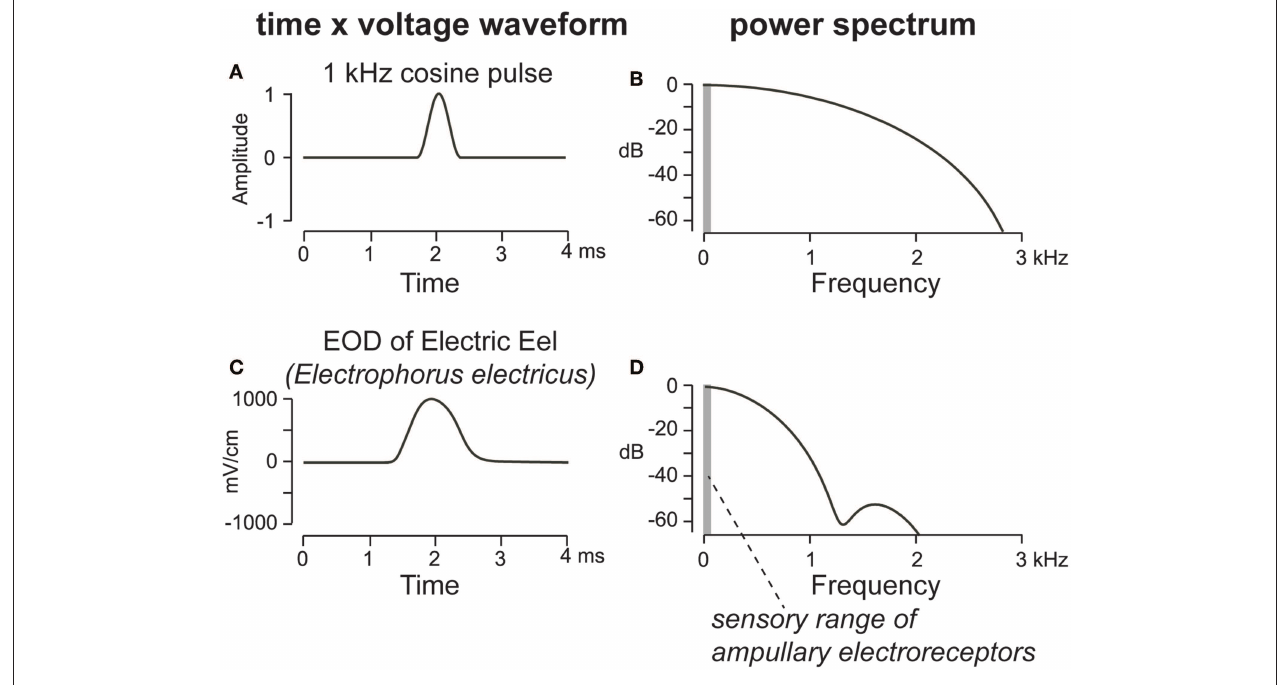
FIGURE 2 | Shown here is a single-period cosine wave (A) , its corresponding power spectrum (B) , and the monophasic pulse EOD of an Electric Eel (C) , the low-voltage signal it produces for electrolocation and communication, with its power spectrum (D) . The energy spectrum of a monophasic EOD pulse ( B or D ) is dominated by low frequencies in the sensory range of ampullary electroreceptors (vertical gray bar) which should make it readily detectable by electroreceptive predators, including catfish and Electric Eels. Adapted from Stoddard and Markham (2008) with permission of the